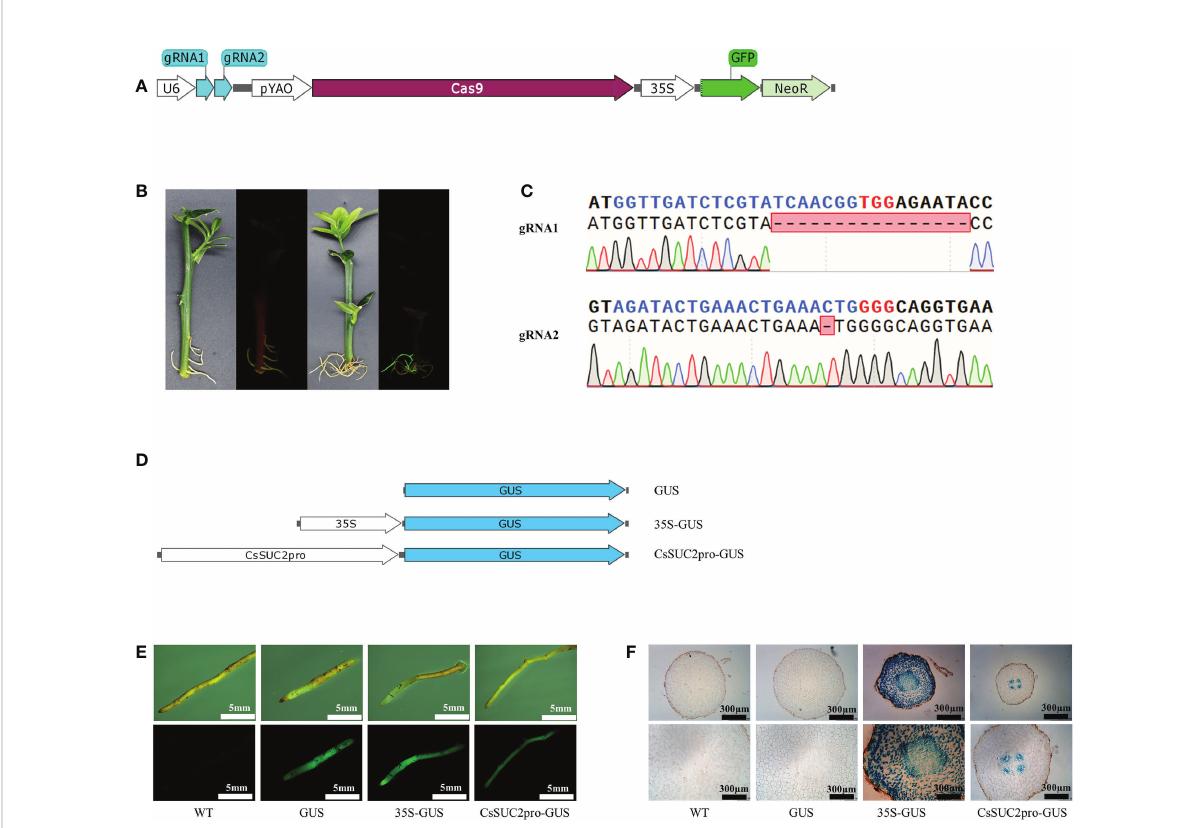
FIGURE 5 Agrobacterium rhizogenes -mediated genetic transformation complements “ hard-to-get ” transgenic materials and facilitates gene function analysis. (A) Schematic diagrams of ACD2 gene-editing elements used in the study. gRNA1 and gRNA2 represent two gRNA scaffolds targeting ACD2 . (B) Green fl uorescence signal visualized by laser scanning confocal microscopy in transgenic tissues of citrus roots. (C) Alignment of the genome-edited sequence of ACD2 -edited hairy roots with the gRNA-targeted loci. (D) Schematic diagrams of vectors containing different types of promoters. (E) Transgenic roots with GFP fl uorescence were obtained after agroin fi ltration using vectors containing different types of promoters. (F) GUS staining of transgenic